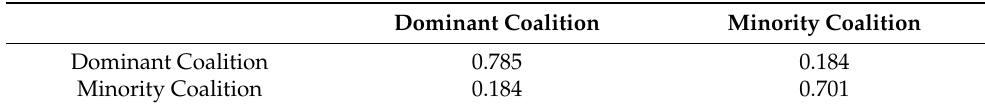
Table 4. Network factions density matrix (2010–2012).